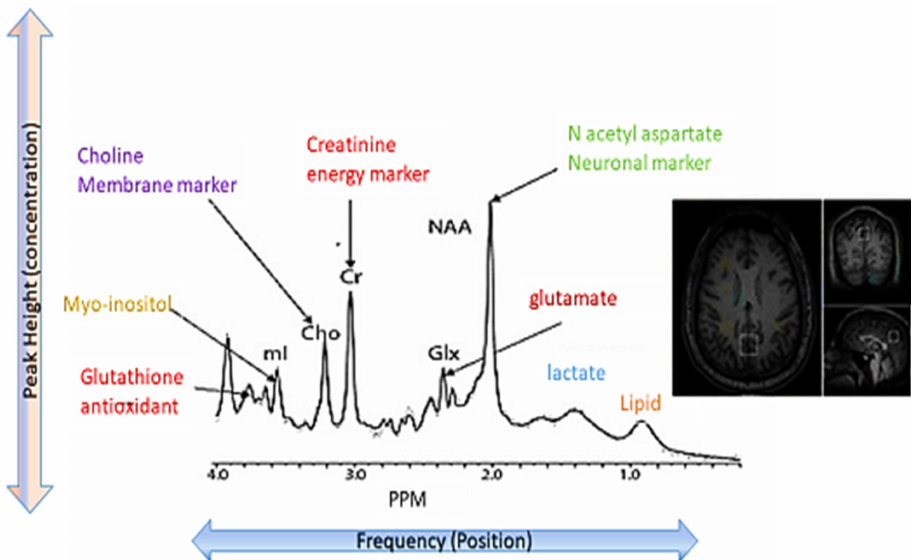
Figure 5. Magnetic resonance spectroscopy measuring major metabolites and providing a window into primary pathophysiological changes happening after TBI. The spectrum denotes the points mI, Cho, Cr, Glx and NAA representing myoinositol, choline, creatinine, glutamate and N-acetyl aspartate, respectively. In detail, myoinositol is a glial marker while choline is a membrane marker. Creatine is linked to mitochondrial function and glutamate is an excitatory neurotransmitter. The biggest spike of N-acetyl aspartate on the spectrum is related to the number of working neurons. (Adopted and modified from [77]).